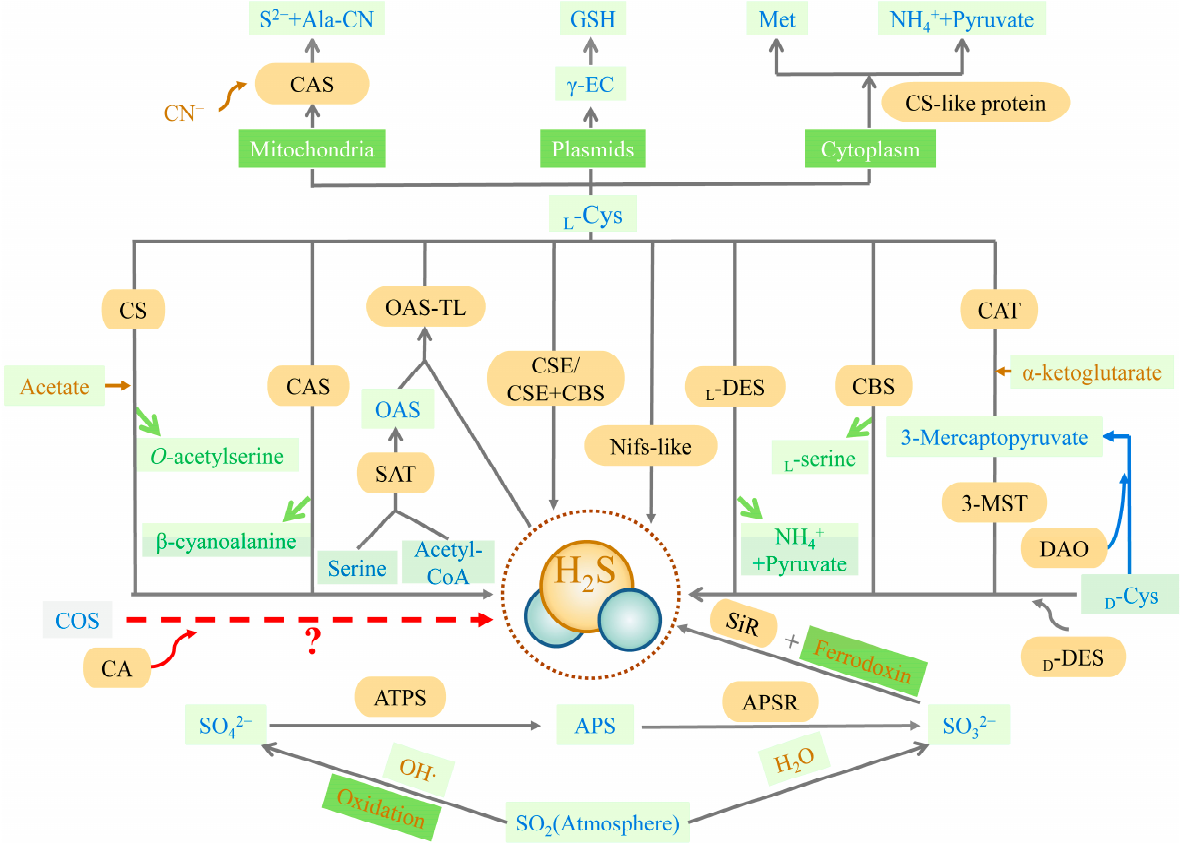
Figure 1. Synthesis of H 2 S. APS (adenosine 5 ′ -phosphosulfate), APSR (APS reductase, EC 1.8.99.2), ATPS (ATP sulfurylase, EC 2.7.7.4), CA (carbonic anhydrase, EC 4.2.1.1), CAS ( L -3-cyanoalanine synthase, EC 4.4.1.9), CAT (cysteine aminotransferase, EC 2.6.1.3), CBS (cystathionine- β -synthase, EC 4.2.1.22), COS (carbonyl sulfide), CN − (cyanide), CS ( O -acetyl- L -serine via cysteine synthase, EC 4.2.99.8), CSC (hetero-oligomeric cysteine synthase complex), CSE (cystathionine- γ -lyase, EC 4.4.1.1), DAO ( D -amino acid oxidase, EC 1.4.3.3), D -Cys ( D -cysteine), D -DES ( D -cysteine desulfhydrase, EC 4.4.1.15), γ -EC ( γ -glutamylcysteine), GSH (glutathione), HO · (hydroxyl radicals), H 2 O (water), H 2 S (hydrogen sulfide), L -Cys ( L -cysteine), L -DES ( L -cysteine desulfhydrase, EC 4.4.1.1), Met (methionine), 3-MST (3-mercaptopyruvate sulfurtransferase, EC 2.8.1.2), NH 4+ (ammonium), Nifs-like (nitrogenase Fe-S cluster-like), OAS ( O -acetyl- L -serine), OSATL ( O -acetylserine(thiol)lyase, EC 2.5.1.47), S 2 − (Sulfide), SAT (serine acetyltransferase, EC 2.2.1.30), SiR (sulfite reductase, EC 1.8.7.1), SO 2 (sulfur dioxide), SO 32 − (sulfite), SO 42 − (sulfate). The closed lines filled with yellow represent enzymes. Rectangles represent substance/organelle reaction conditions. Rectangles filled with light green represent substances (wherein the blue-lettered cells are pivotal substances, yellow-lettered cells are involved in the synthesis of substrates, and green-lettered cells are reaction synthesis byproducts). Rectangles filled with dark green represent substance organelles/reaction conditions (wherein the white-lettered cells are organelles and the yellow-lettered cells are reaction conditions). Yellow arrows represent the substrates involved in the reaction, green arrows represent byproducts of the reaction, and red arrows represent the need for verification by further research. The reactions involved in the blue arrows are not currently found in